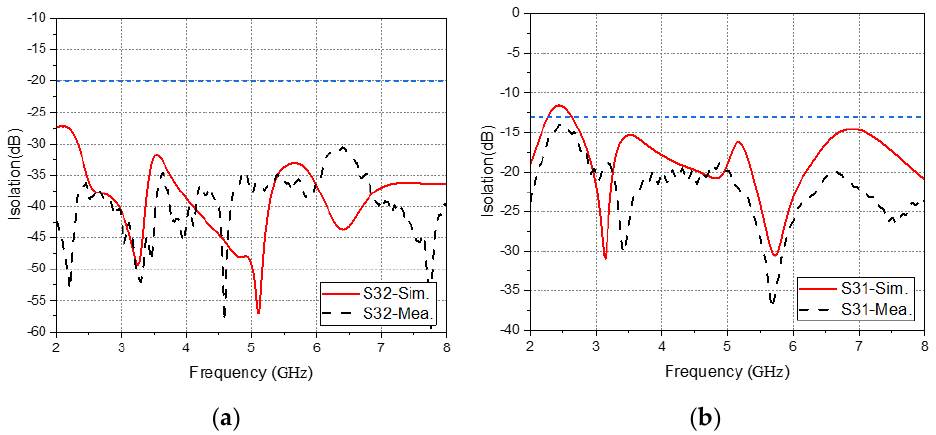
Figure 17. ( a ) Simulation and measurement of isolation of Ant. 2 and Ant. 3 ( b ) simulation and measurement of isolation of Ant. 1 and Ant. 3.